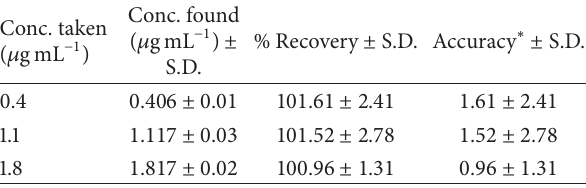
Table 2: Evaluation of accuracy of the proposed method for ganciclovir determination in pure form.